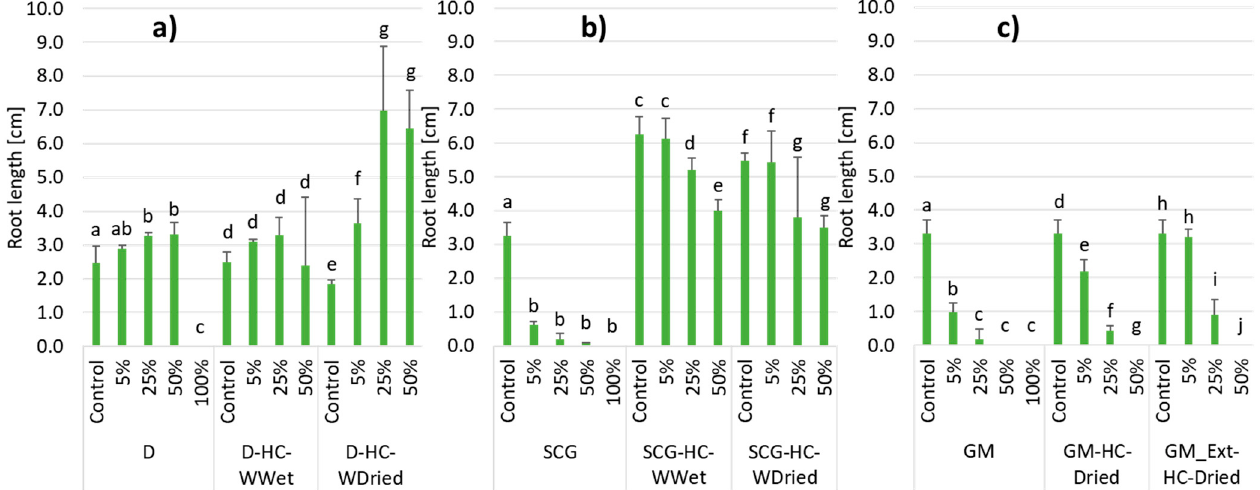
Figure 4. Average root length of seedlings deriving from germination tests using ( a ) D and the related wet and dried hydrochar, ( b ) SCG and the related wet and dried hydrochar, and ( c ) GM and the related dried hydrochar. Samples connected by the same letters are not significantly different.